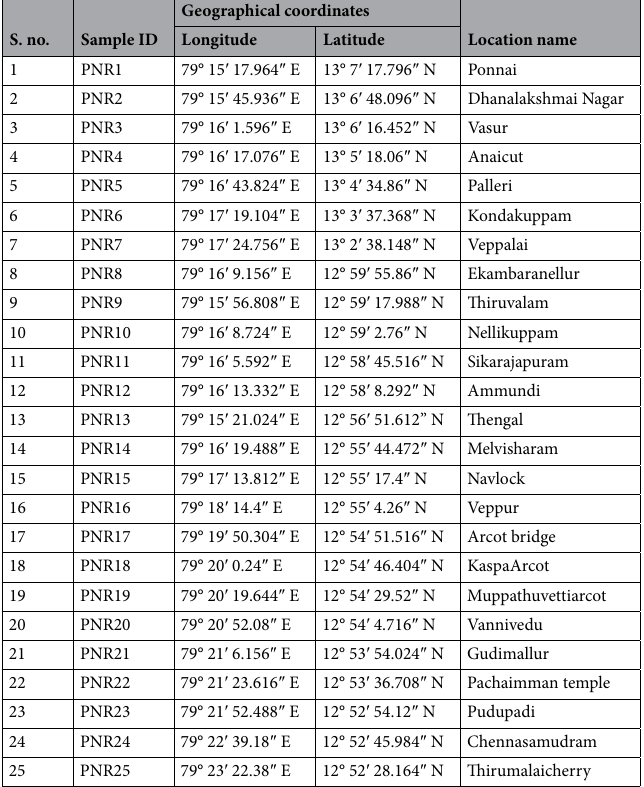
Table 1. Geographical information of Sampling locations in Ponnai River,